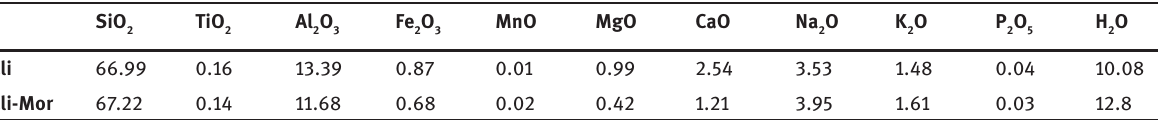
Table 2: ICP-AES chemical analysis (expressed as oxides %w/w).